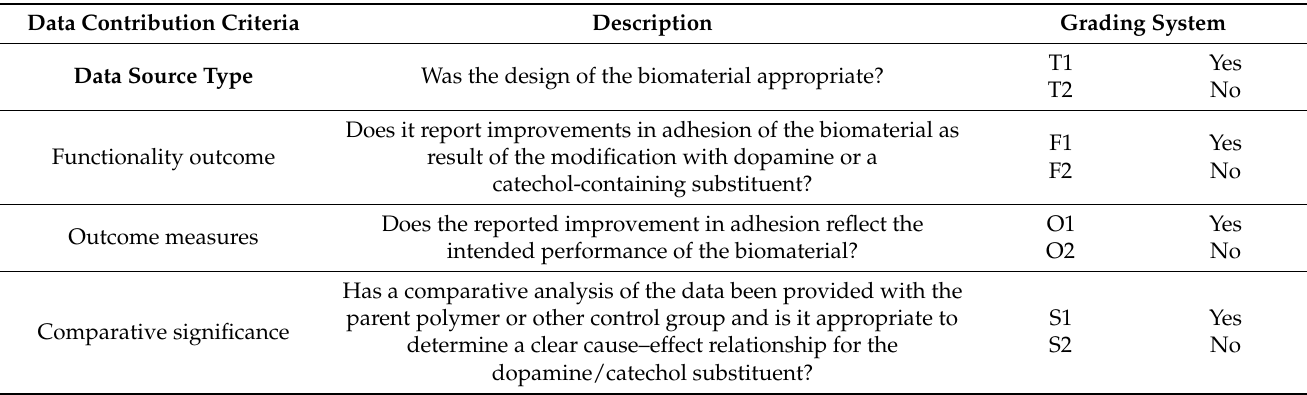
Table 1. Appraisal criteria for assessment of manuscripts towards inclusion/exclusion from the final reference list.